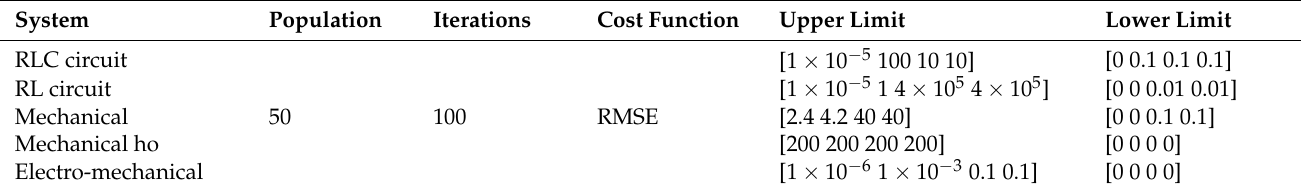
Table 1. General parameters for Jaya and GWO algorithms.